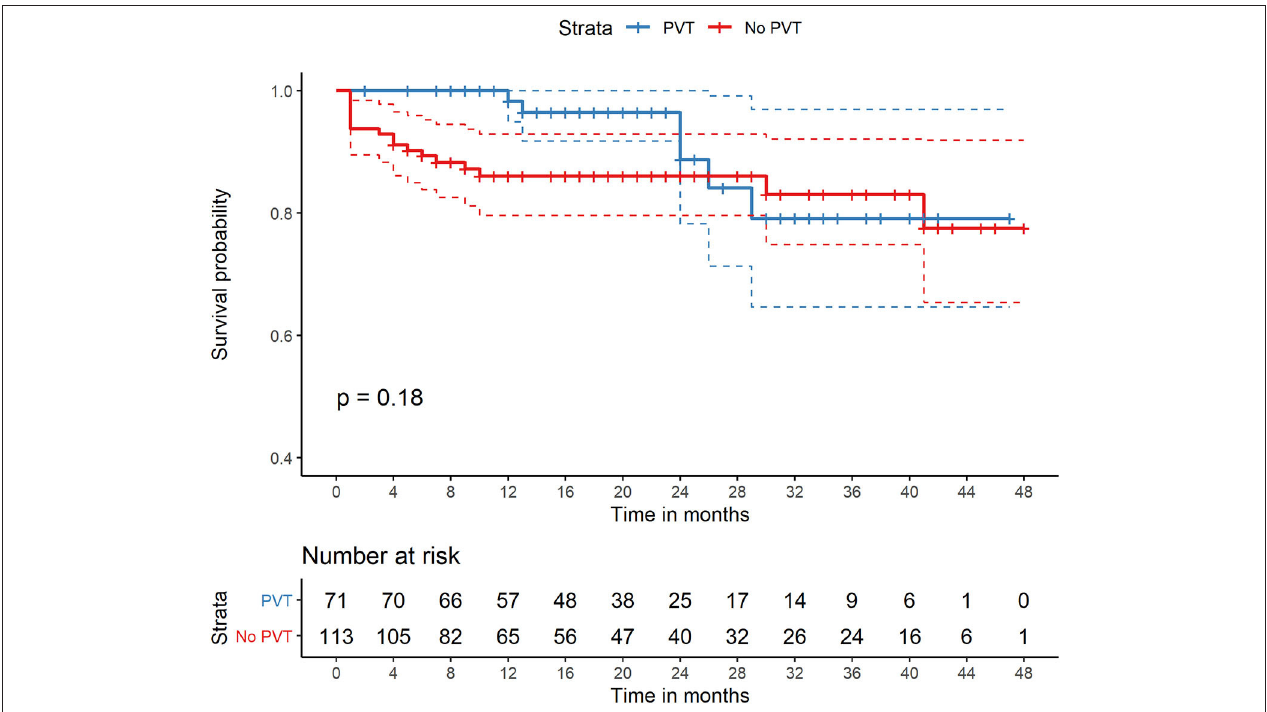
FIGURE 1 | Comparison of survival of patients with PVT and without PVT who were all treated with TIPS. PVT, portal vein thrombosis; TIPS, transjugular intrahepatic portosystemic shunt.